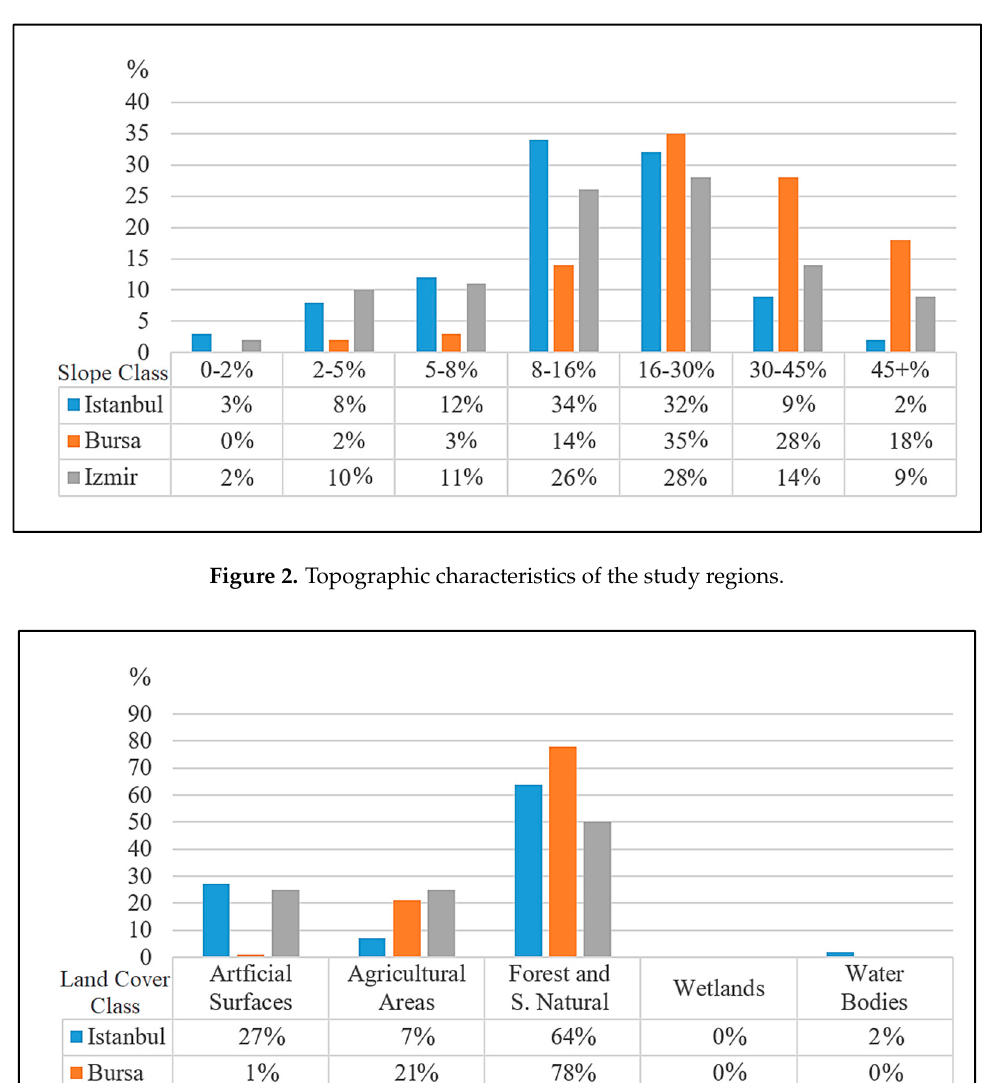
Figure 3. Land cover (LC) characteristics of the study regions.